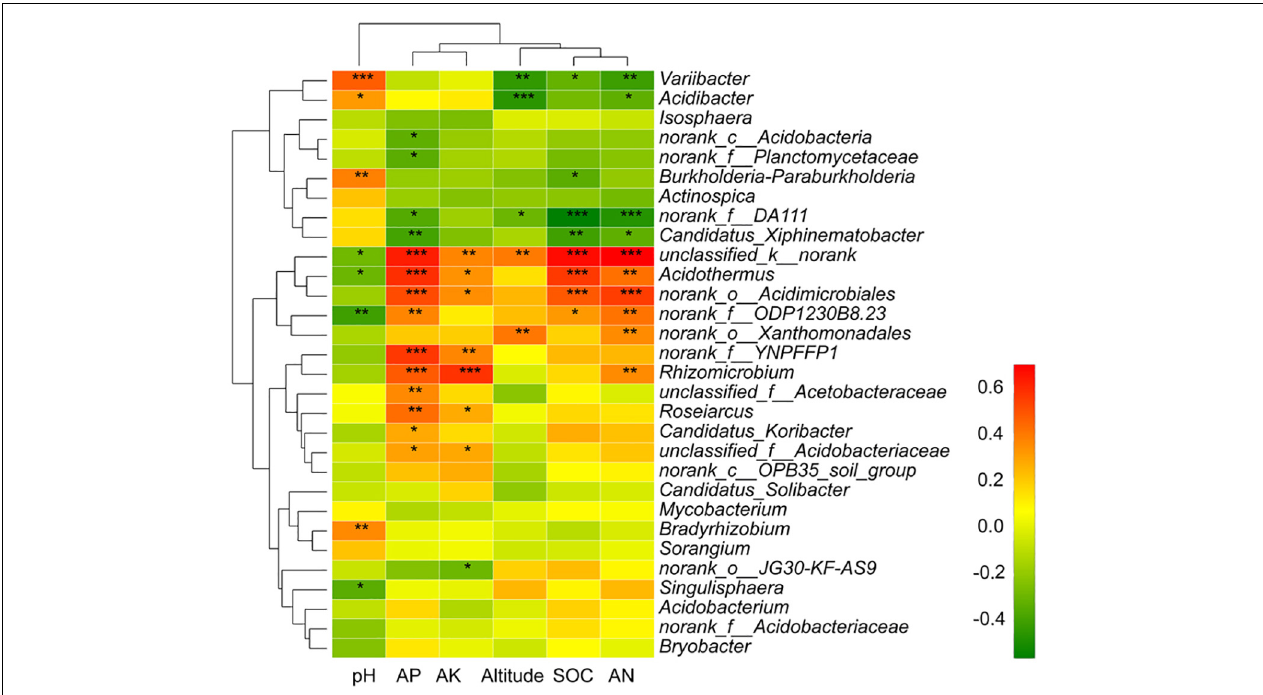
FIGURE 8 | The Spearman correlation of the top 30 genera and soil/site properties. Significant differences by * p < 0.05; ** p < 0.01 and *** p < 0.001.